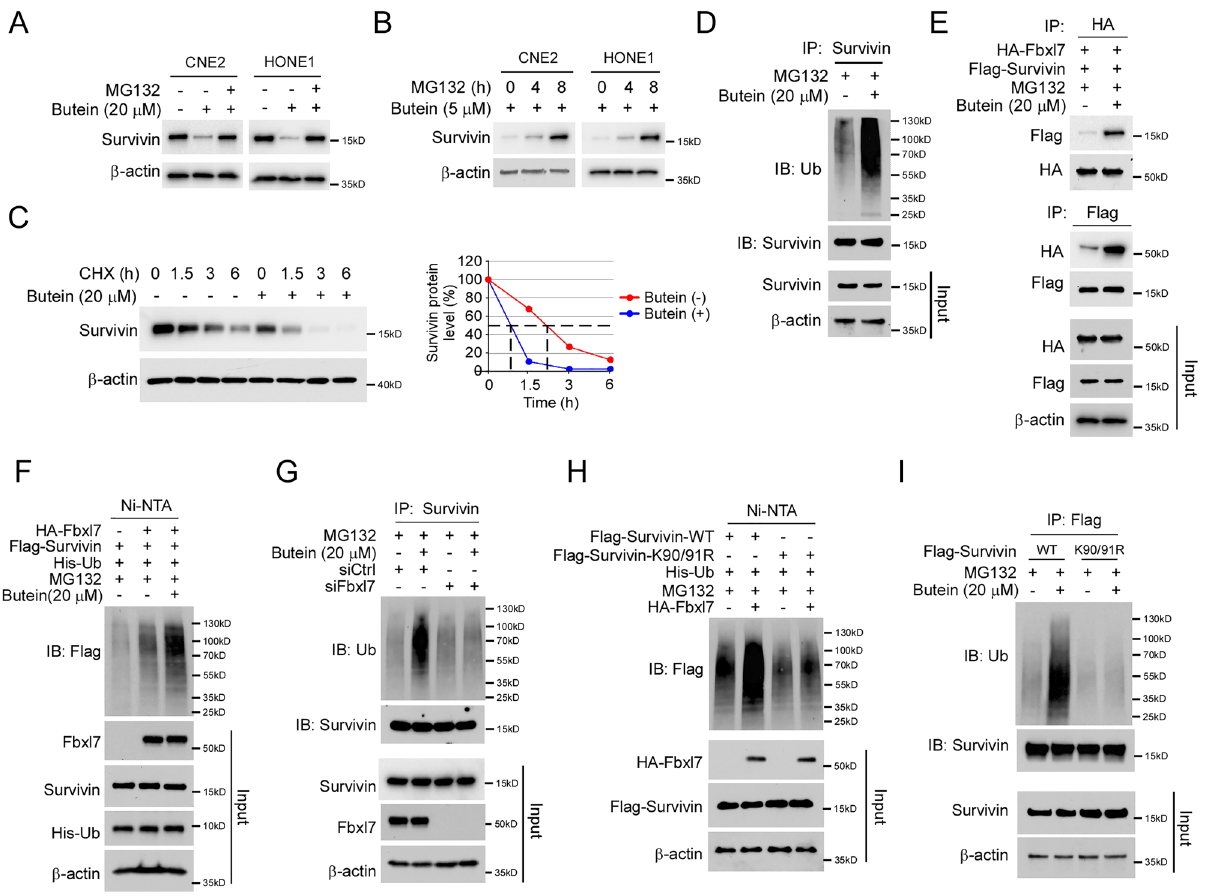
Figure 3. Butein promotes survivin ubiquitination. ( A ) CNE2 and HONE1 cells were treated with Butein for 24 h, and incubated with MG132 (20 µM) for 8 h. The whole-cell extract (WCE) was subjected to IB analysis. ( B ) CNE2 and HONE1 cells were treated with Butein for 24 h, and incubated with MG132 (20 µM) for various time points. The WCE was subjected to IB analysis. ( C ) CNE2 cells were treated with Butein for 24 h, and incubated with CHX for different time points. The WCE was subjected to IB analysis. ( D ) CNE2 cells were treated with Butein for 24 h, and incubated with MG132 (20 µM) for 8 h. The WCE was subjected to survivin ubiquitination analysis. ( E and F ) CNE2 cells were transfected with various constructs for 24 h, followed by Butein treated for 24 h, and incubated with MG132 (20 µM) for 8 h. The WCE was subjected to co-IP ( E ) or survivin ubiquitination ( F ) analysis. ( G ) CNE2 cells were transfected with siFbxl7 for 24 h and treated with Butein for another 24 h. WCE was collected after the cells were incubated with MG132 (20 µM) for 8 h. The WCE was subjected to survivin ubiquitination analysis. ( H and I ) CNE2 cells were transfected with various constructs for 24 h, followed by Butein treated for 24 h, and incubated with MG132 (20 µM) for 8 h. The WCE was subjected to survivin ubiquitination